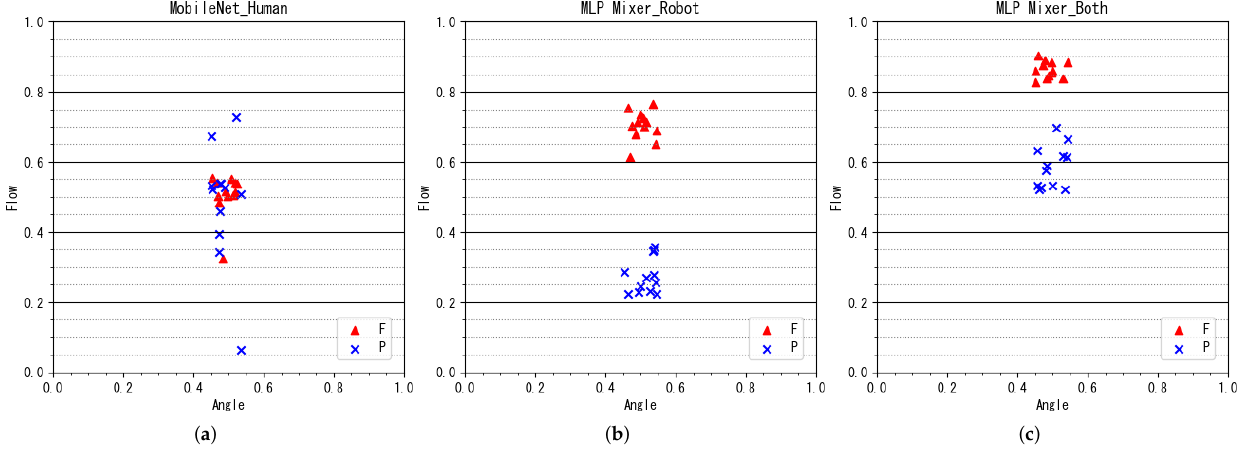
Figure 9. Examples of flow estimation results. ( a ) MobileNet and human dataset (conventional method). ( b ) MLP-Mixer and robot dataset (proposed method). ( c ) MLP-Mixer and robot + human datasets (proposed method).